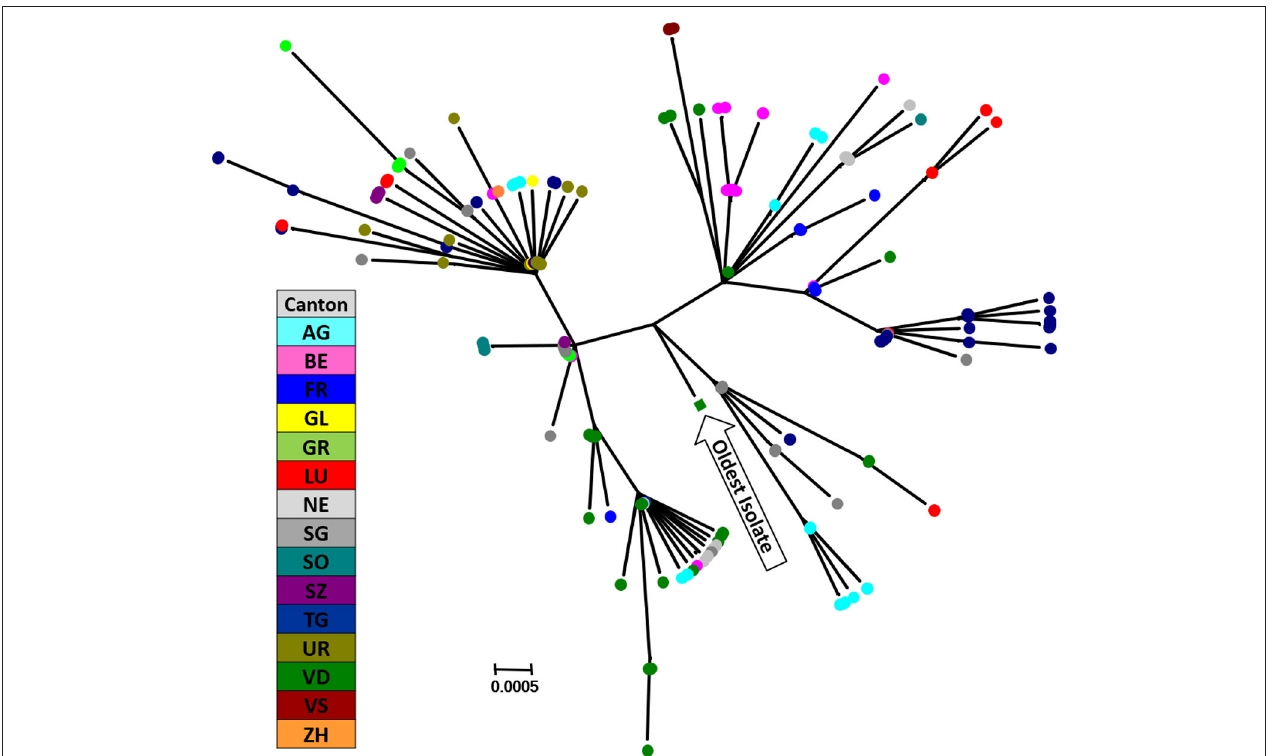
FIGURE 4 | Phylogenetic analysis of an alleged infection chain analysing samples with identical sequences in the 5-UTR. Fragments of 978 bp in the NS2-3 region of the viral genome were sequenced and are shown in a phylogenetic tree. Each circle represents one single sequence from a PI animal sampled between May 2015 and February 2019, with different colours per canton representing the place of birth of the PI animal. The most antecedent sample within this cluster is indicated. The evolutionary history was inferred by using the Maximum Likelihood method based on the Kimura 2-parameter model (184), and the tree with the highest log likelihood is shown. A discrete gamma distribution was used to model evolutionary rate differences among sites. The tree is drawn to scale, with branch lengths measured in the number of substitutions per site. There are maximally 11 nucleotide difference between these samples (median = 5). The analysis involved 214 nucleotide sequences. Codon positions included were 1st + 2nd + 3rd + non-coding. There were a total of 927 positions in the final dataset. Evolutionary analyses were conducted in MEGA7 ( 18). The nucleotide sequences used were submitted to GenBank, accession no.